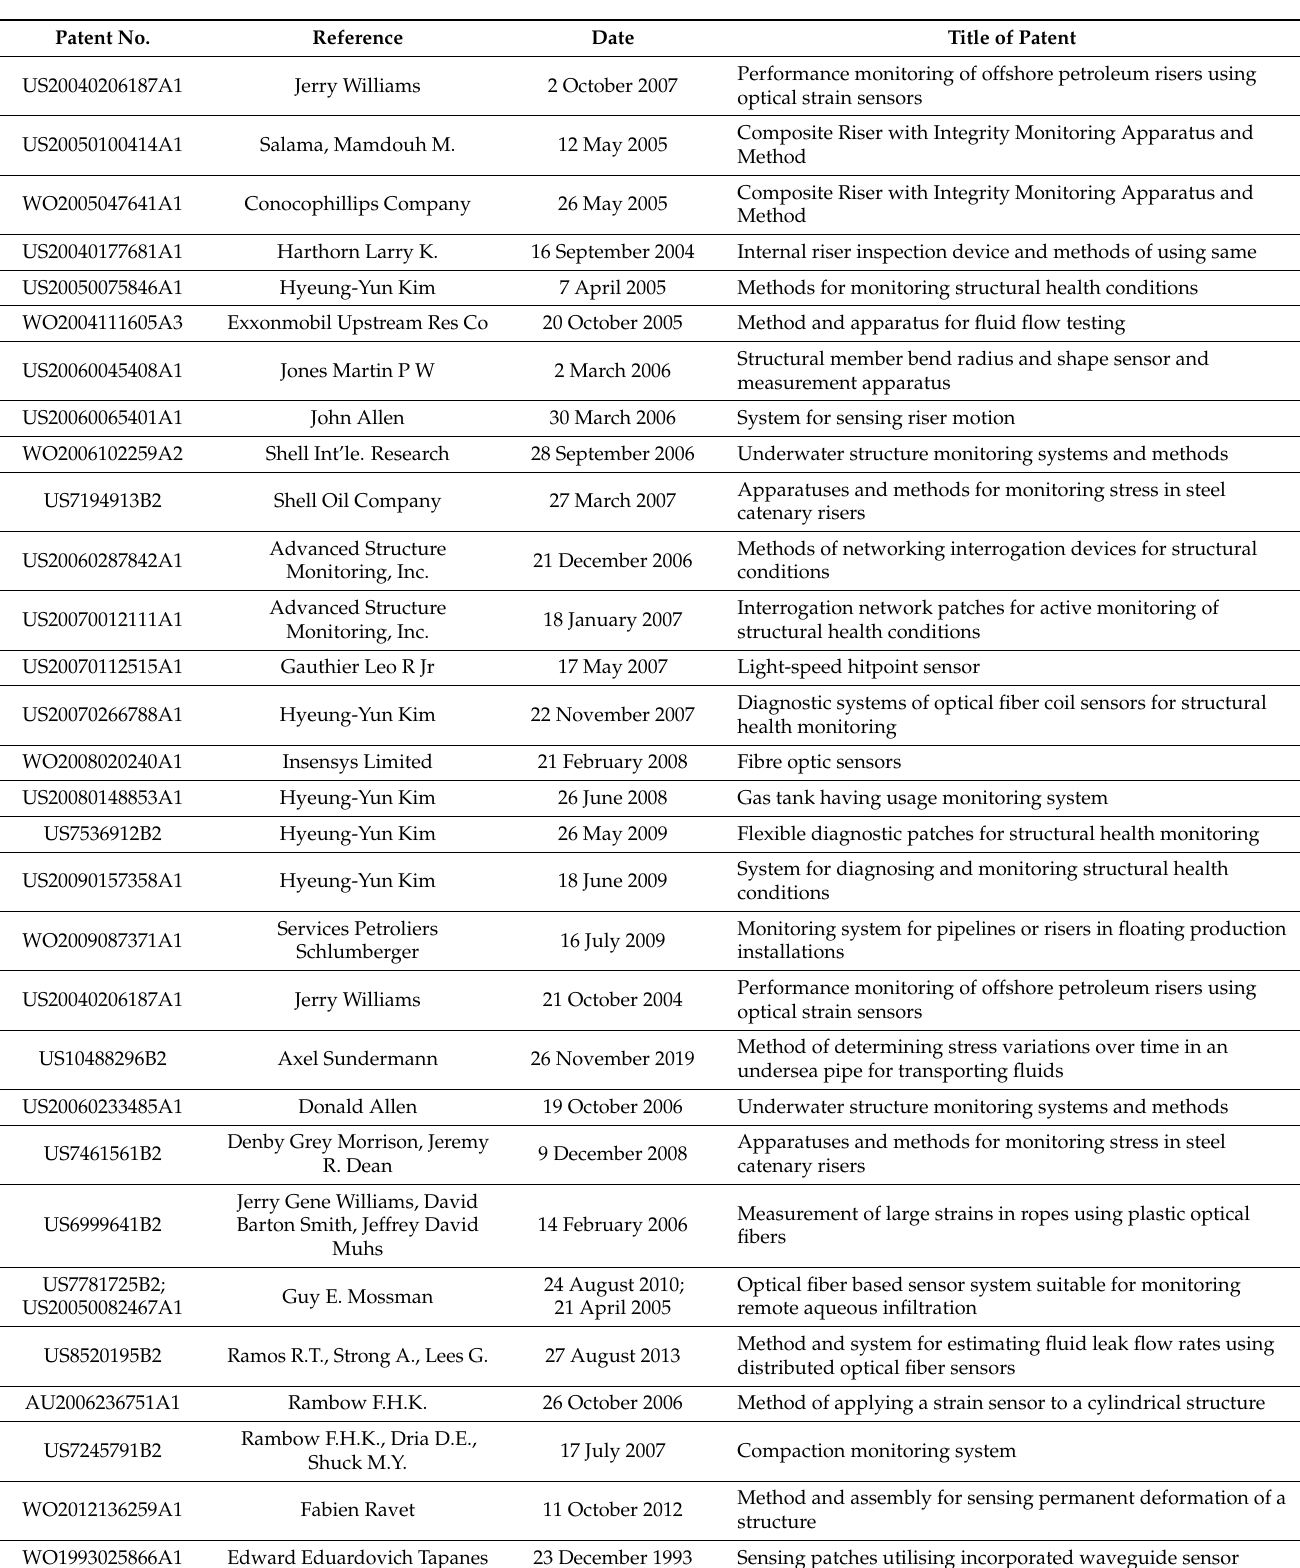
Table 4. Patent list for innovations in monitoring devices with methods for composite risers and steel